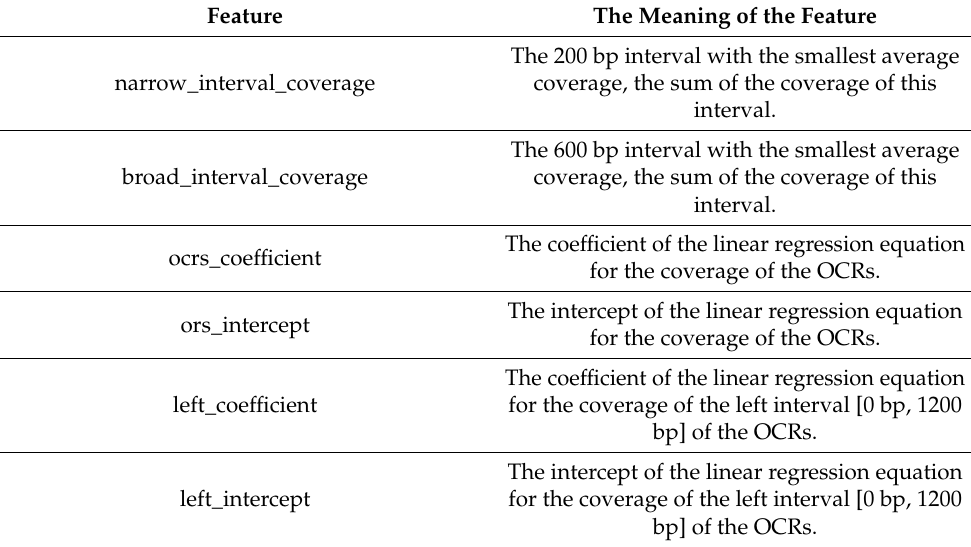
Table A2. The names and meanings of the features related to sequencing